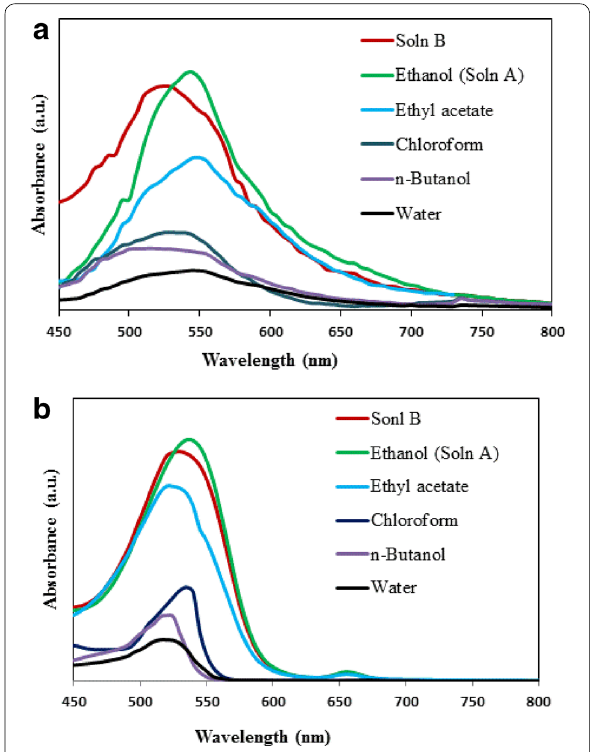
Fig. 9 UV‑vis absorption spectrum of the extracts with different solvents from a Jamaica flowers and b Mortiño